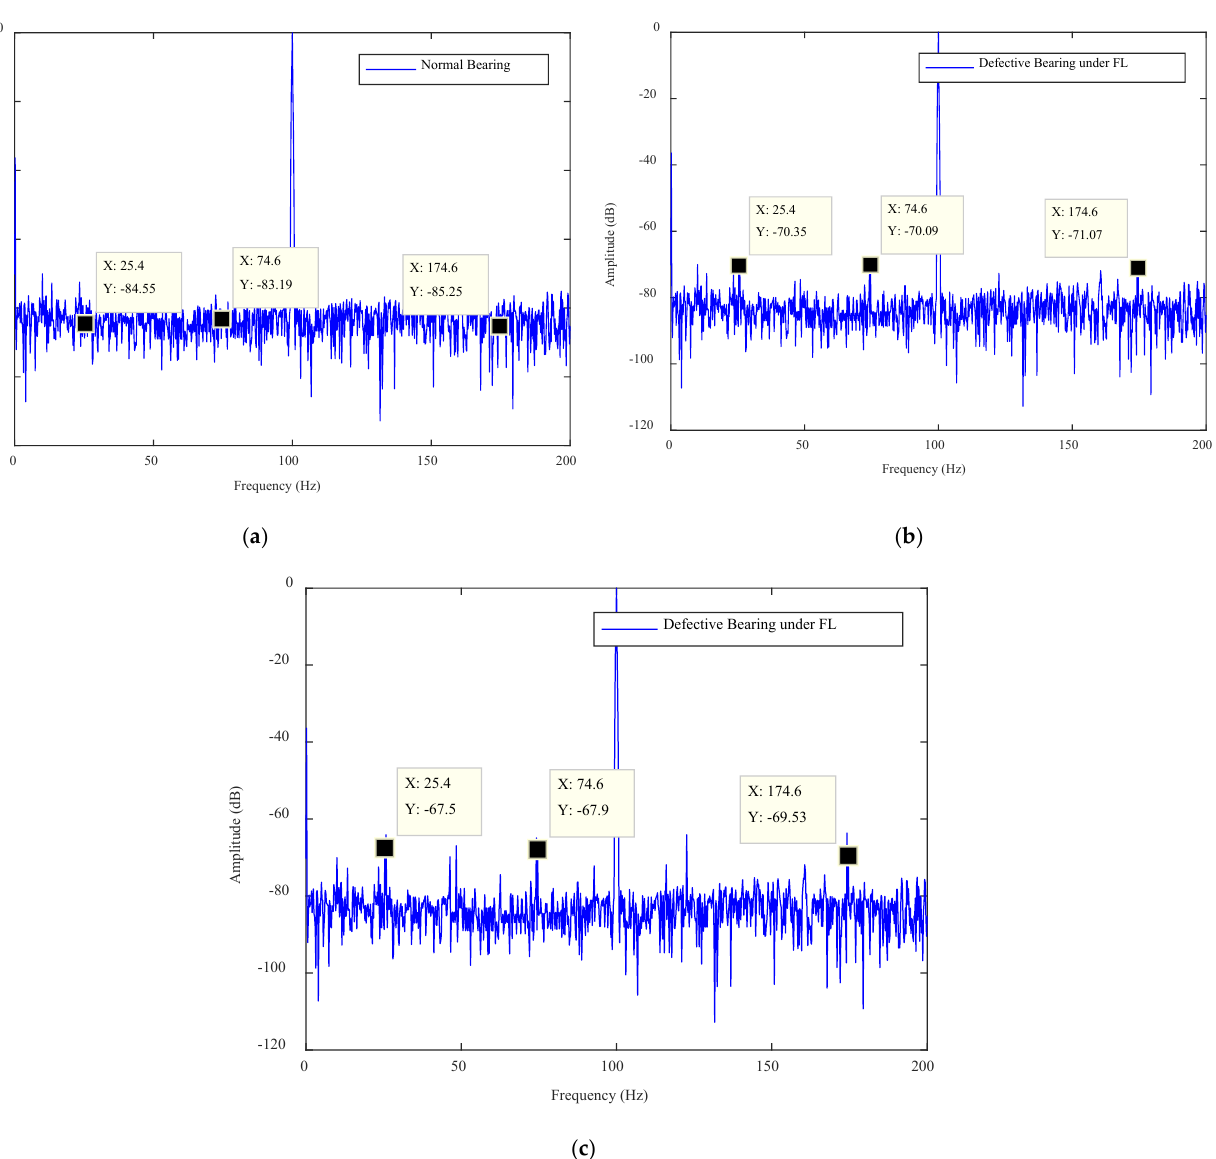
Figure 8. The FL plots for the defective bearing: ( a ) normal bearing, ( b ) type 1 defect and ( c ) type 2 defect.